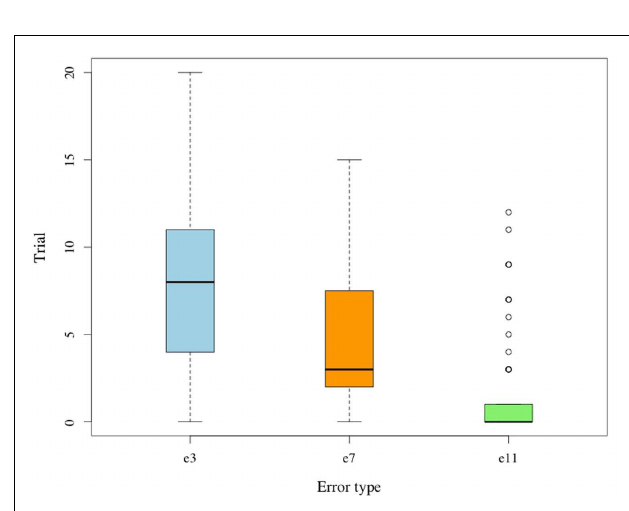
FIGURE 5 | Last trial for error. Whisker plot of trial during which the last error occurred; separated by